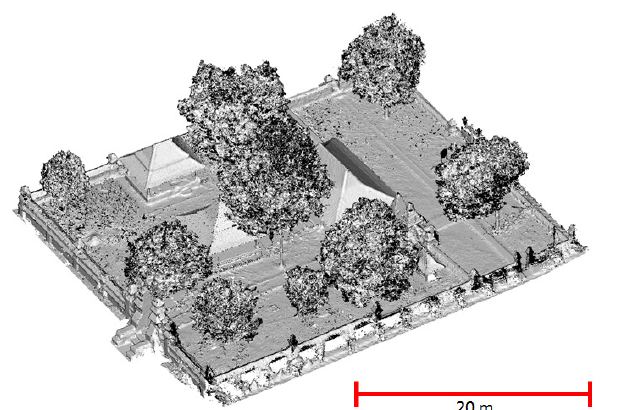
Figure 3. The GIS shapefile data used in aiding the segmentation process. Three classes of interest are shown here superposed on the orthophoto image.